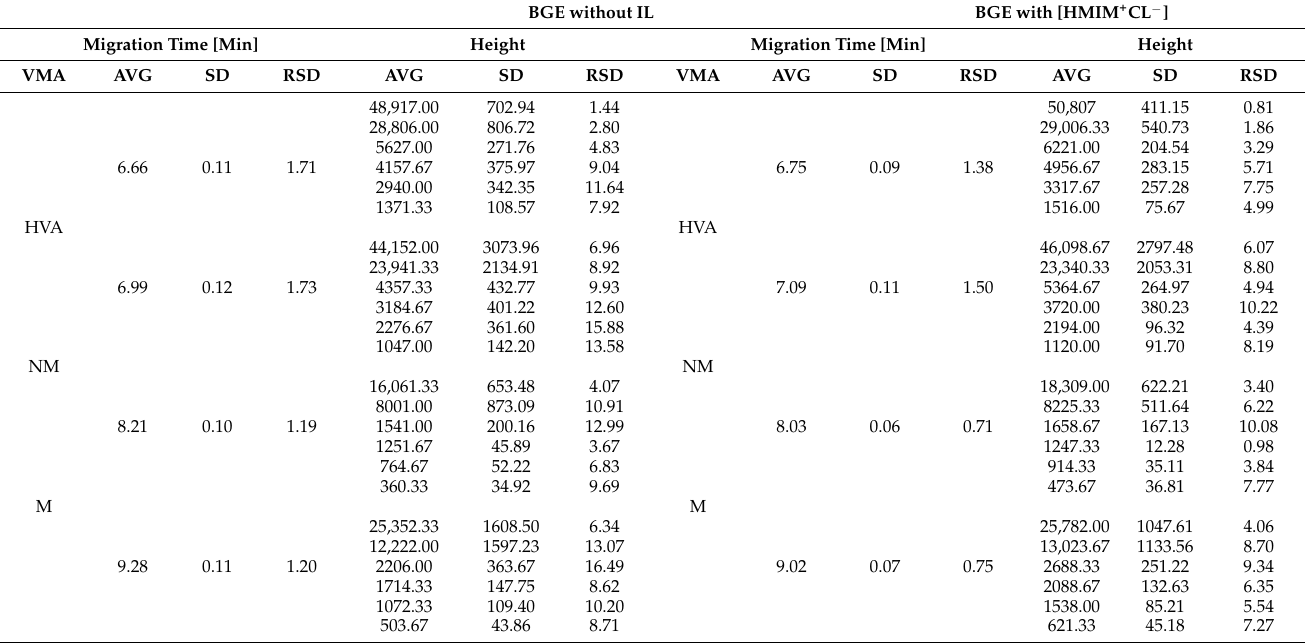
Table 2. Migration times and peak heights obtained during the analysis of the tested compounds using BGE without the addition of IL and with the addition of [HMIM + CL − ] (n = 3). BGE without IL BGE with [HMIM + CL − ] Migration Time [Min] Height Migration Time [Min]